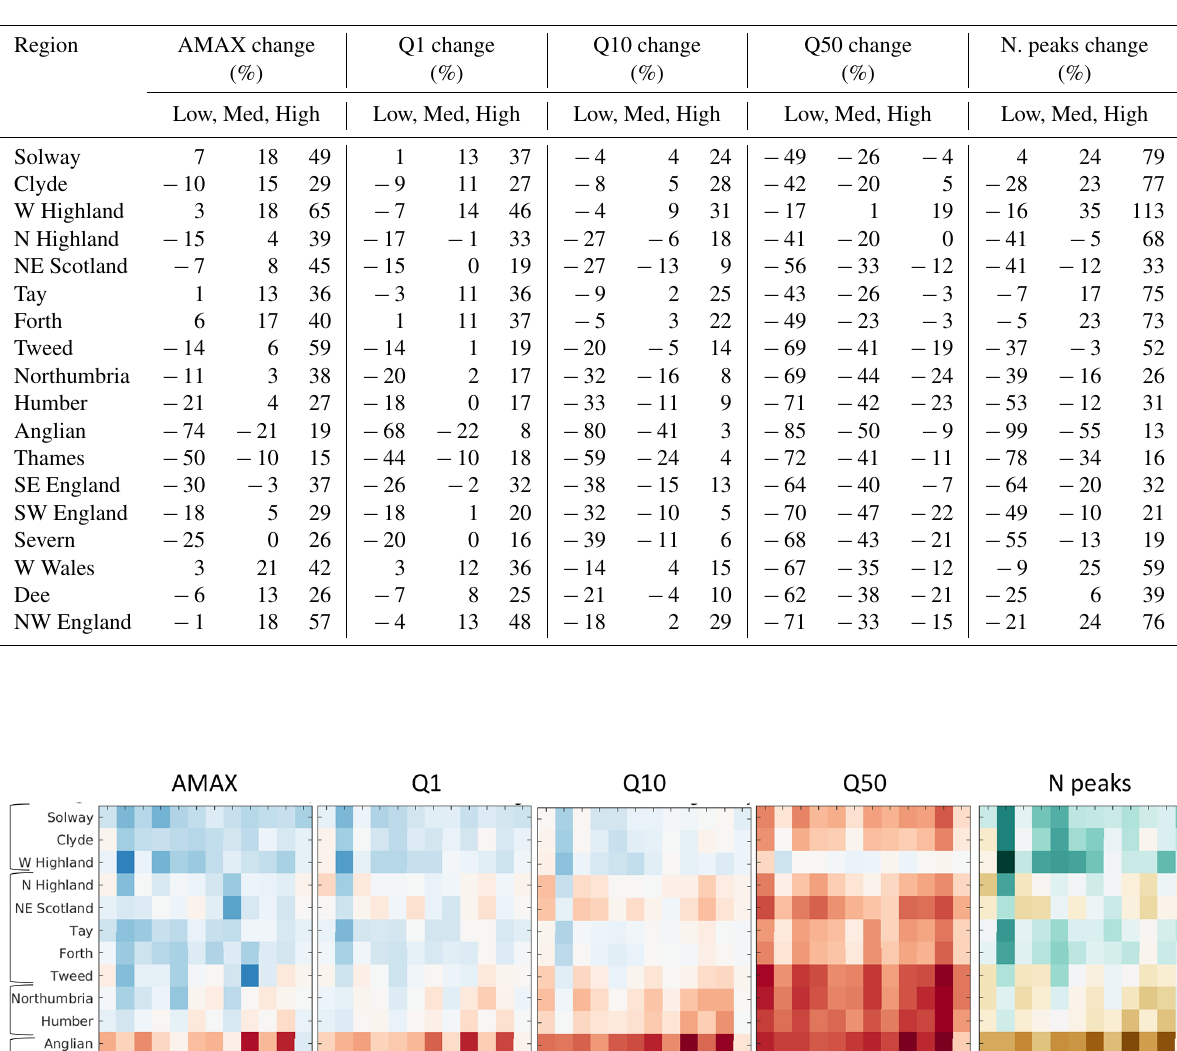
Table 1. Ensemble range in projected changes for each flow metric. All changes are given as percentage differences between the baseline and future periods. “Low”, “Med”, and “High” refer to the lowest, median, and highest region-average changes from the ensemble of RCM and hydrological model parameters.